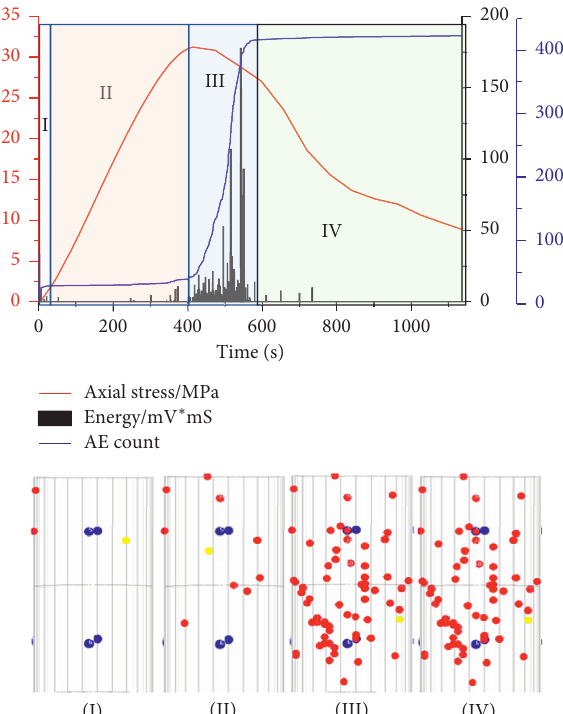
Figure 7: Four-parameter-time relationship for